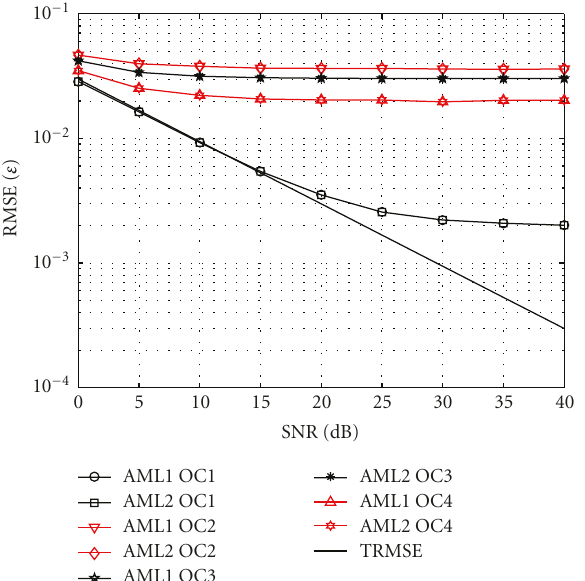
Figure 2: Performance of the proposed AML CFO estimators in ITU Vehicular A multipath